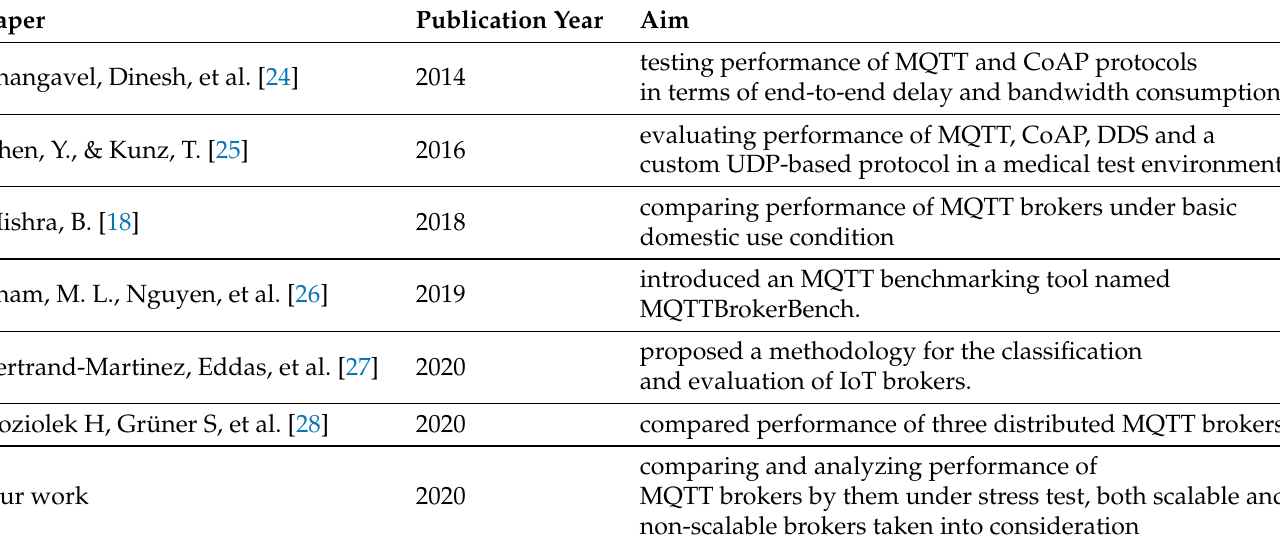
Table 1. Comparison of related works according to their main